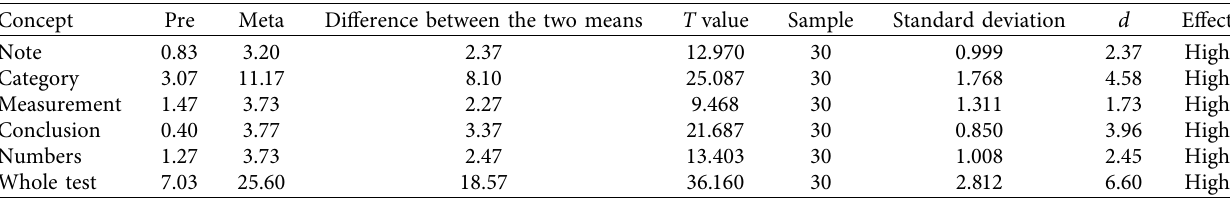
Table 10: Influence magnitude